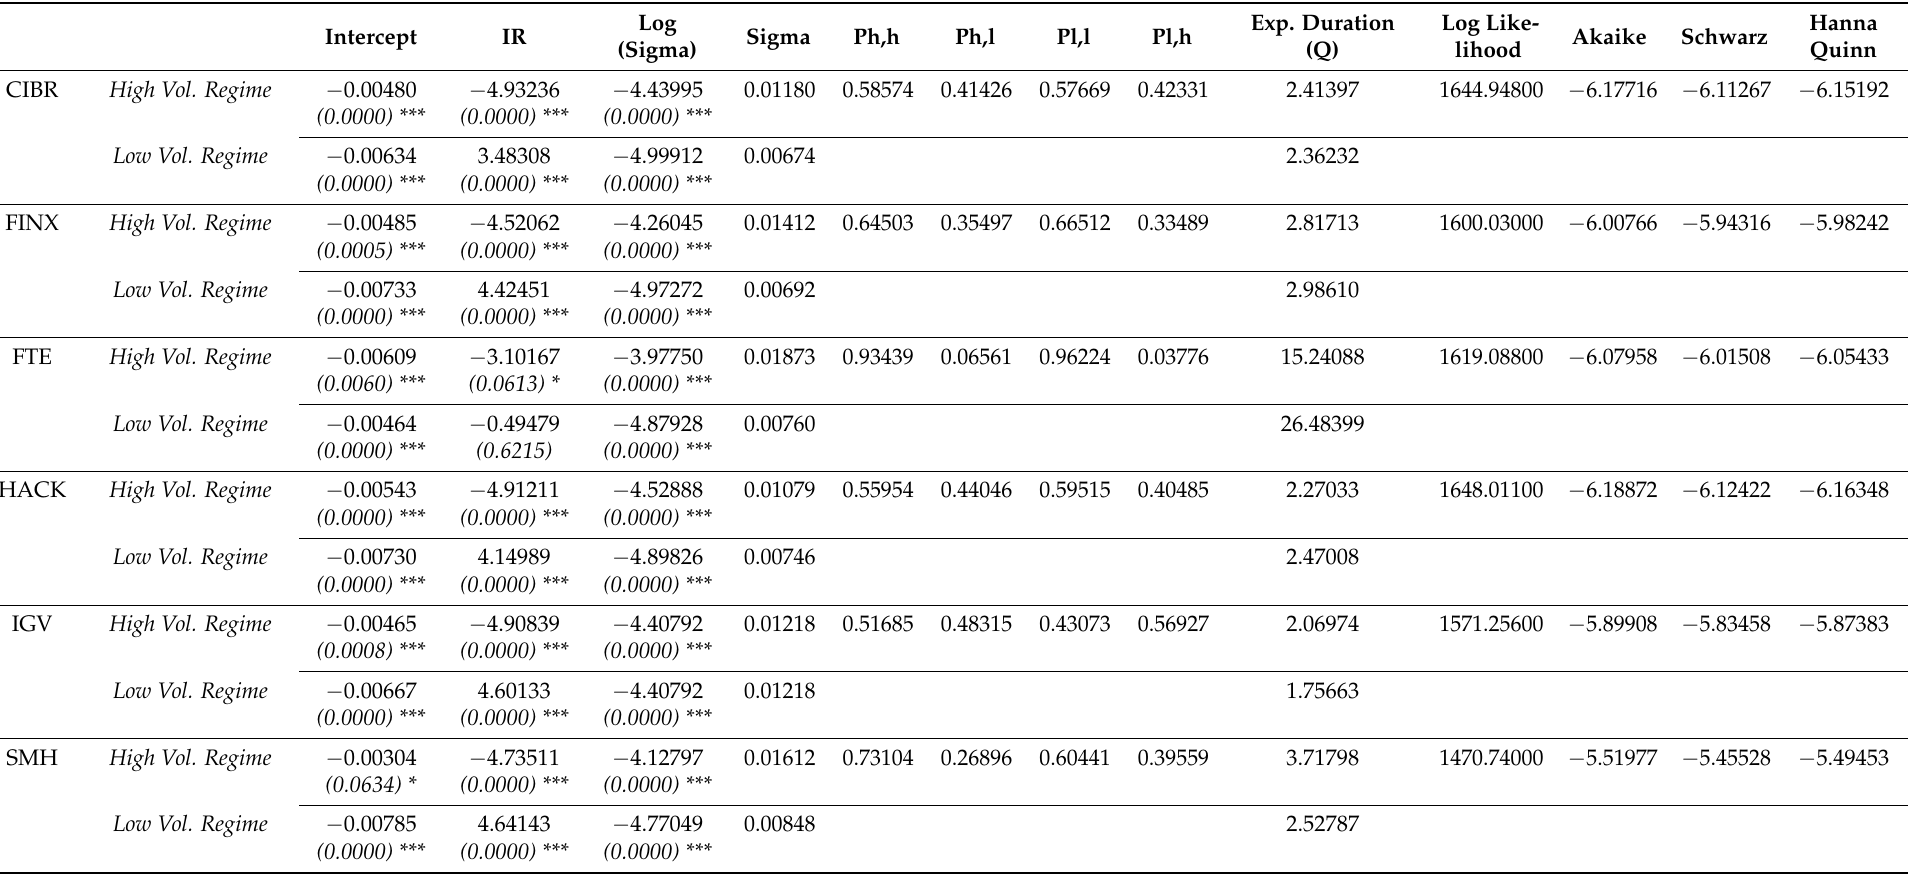
Table 2. Heteroscedastic Markov regime-switching (MRS) for high-tech ETFs excess returns, individual idiosyncratic risk, and excess return in two